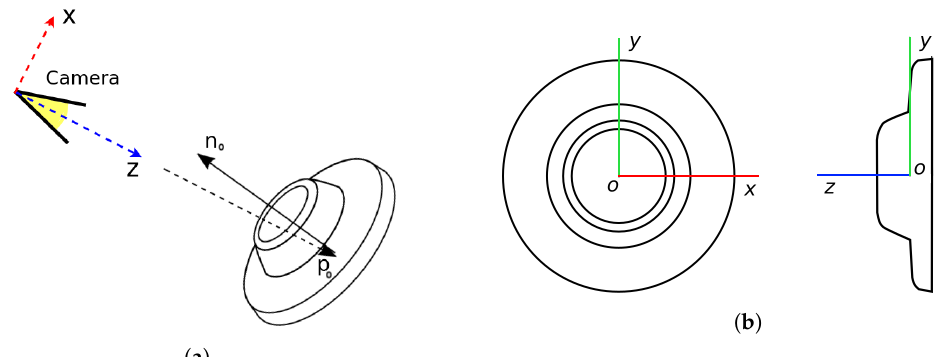
Figure 9. Thepartcoordinatesystem. ( a )Positionandorientationofthepart. ( b )Objectcoordinate system.